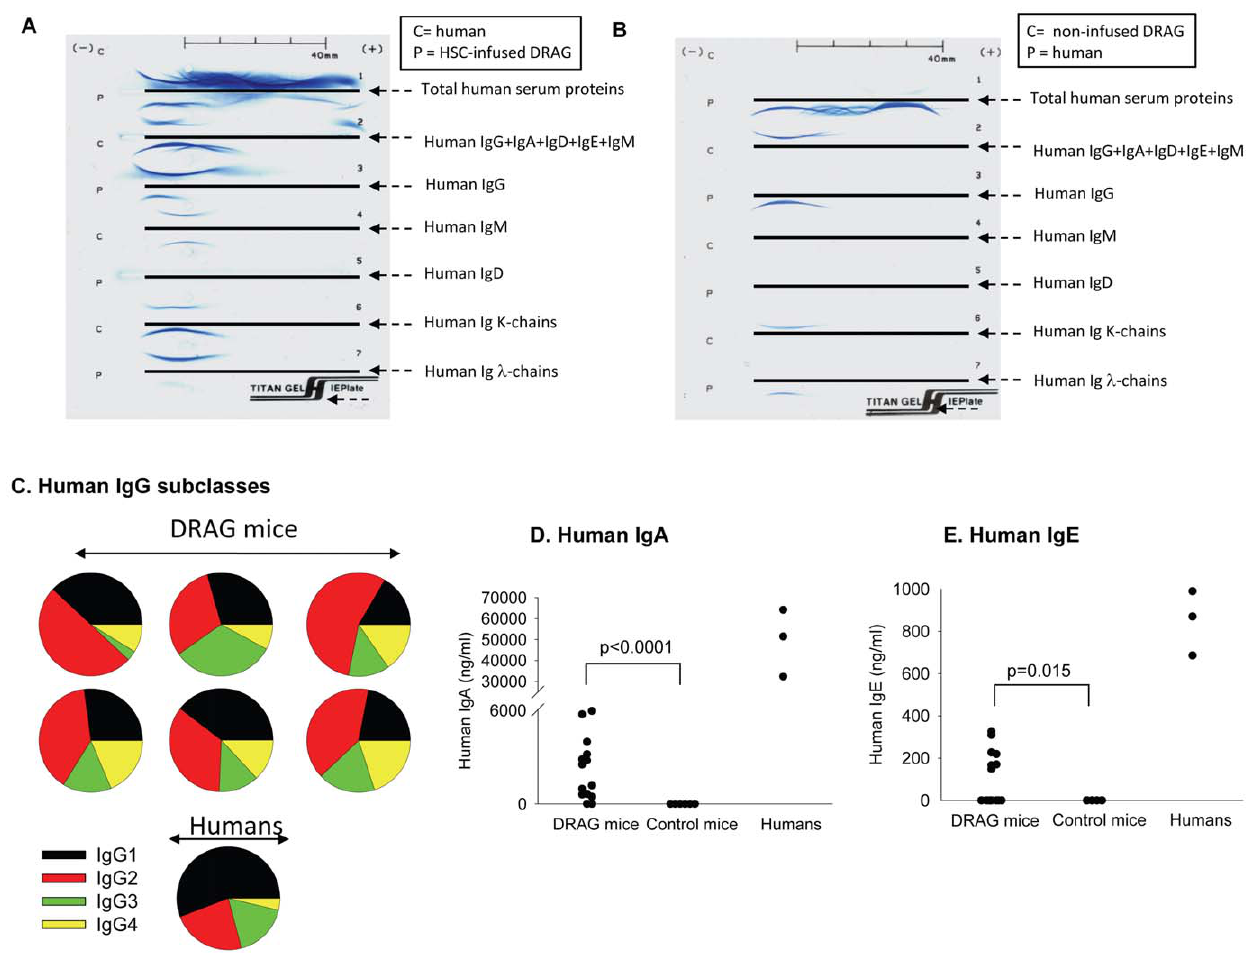
Figure 6. B cells from DRAG mice undergo immunoglobulin class switching. Panels A and B, immunoelectrophoresis of plasma proteins from DRAG mice at 6 months post-infusion of HSC or prior to infusion with HSC, respectively. Panel C, percentage of human IgG subclasses within the total human IgG fraction in plasma of six DRAG mice examined. Panel D, 12 out 14 (85.7%) DRAG mice that showed human B cells in blood, reconstituted human IgA in plasma. Data present mean values of mice analyzed individually. Panel E, 7 out of 14 (50%) DRAG mice also reconstituted human IgE in plasma. No human IgA or IgE was detected in plasma of control mice (p values , 0.0001 and 0.015, respectively by Mann-Whitney test).